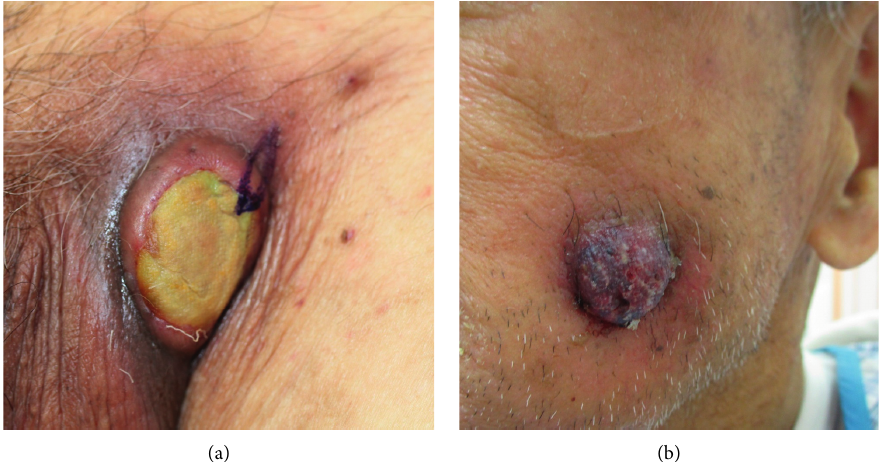
Figure 2: Cutaneous tumor lesions. (a) A painful cutaneous tumor, the top of which showed yellow-colored necrosis, which developed at the left groin 8 months after the second discontinuation of azacitidine. (b) Another cutaneous tumor, which appeared on the left cheek one month after the development of the first cutaneous lesion at the left